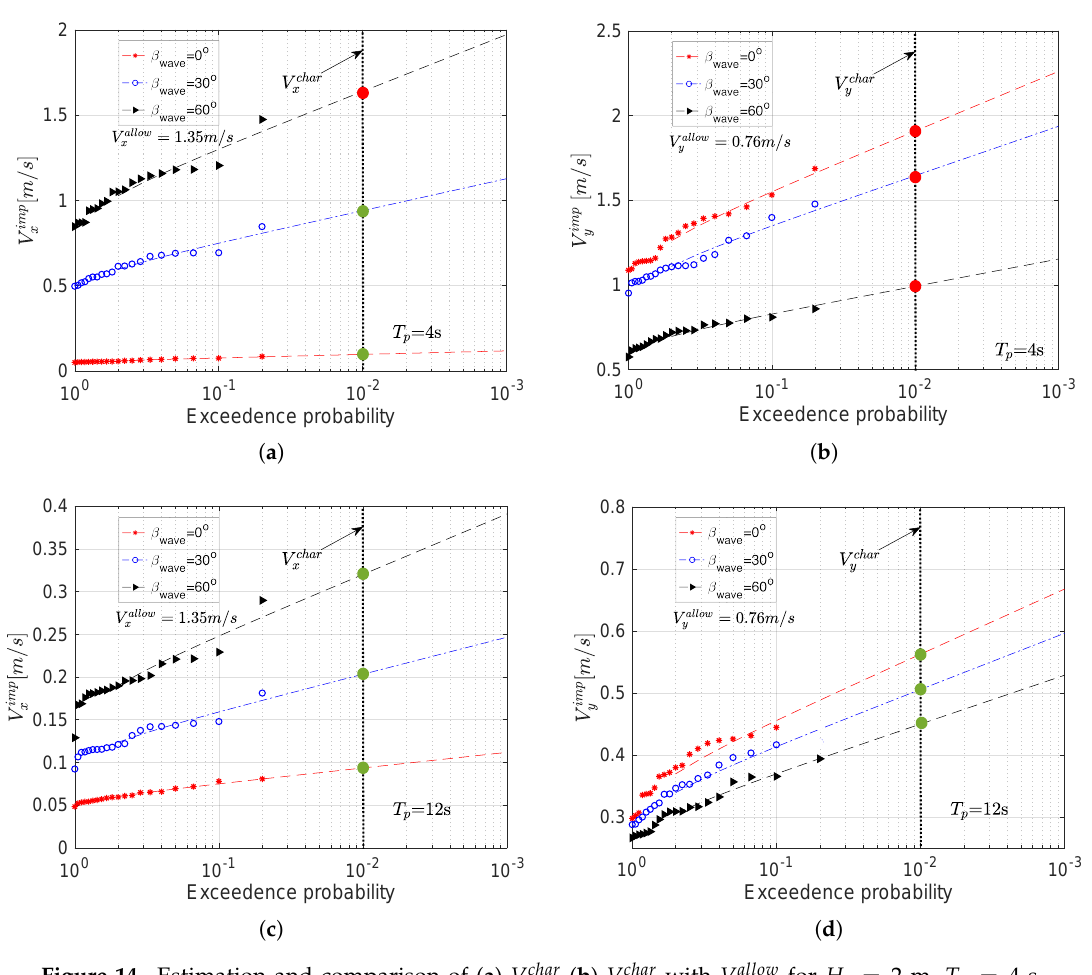
Figure 14. Estimation and comparison of ( a ) V char x ( b ) V char y with V allow x , y for H s = 2 m, T p = 4 s, U w = 8 m/s and β wave = 0°, 30° and 60°; Estimation and comparison of ( c ) V char x ( d ) V char y with V allow x , y for H s = 2 m, T p = 12 s, U w = 8 m/s and β wave = 0°, 30° and 60° (green dots: V char x , y ≤ V allow x , y and red dots: V char x , y ≥ V allow x , y